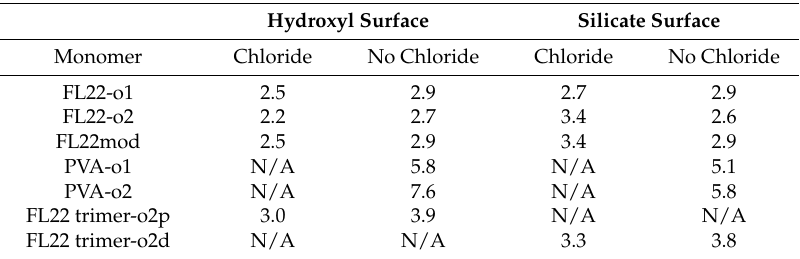
Figure 10. Orientation 2 (o2)—configurations after relaxation of the simulated monomer unit and kaolinite surface in the chloride and charge only models. Table 4. Two examples of surface coverage for two of the trimers lying parallel (p) and diagonal (d) to the surfaces (Figure 3), and surface coverage of kaolinite basal surfaces for the relaxed configurations of the orientations 1 (o1) and 2 (o2) of FL22, FL22mod and PVA, (Figures 9 and 10). Units in monomers/nm 2